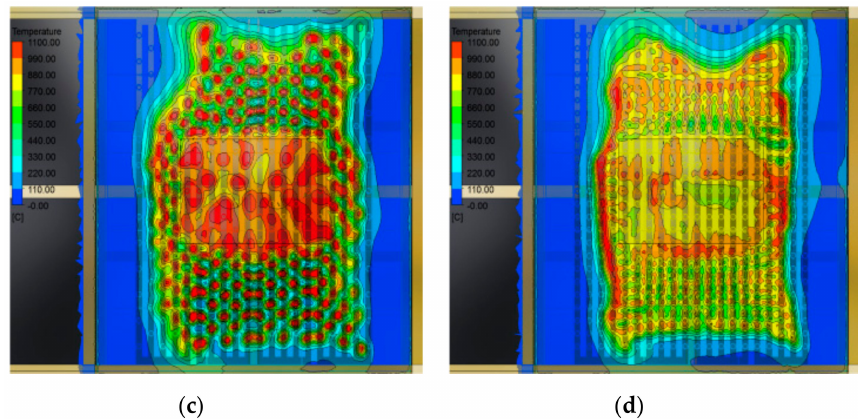
Figure 11. Temperature distribution at measurement plane (25 ± 10 mm downward from the bottom of mock-up): ( a ) test apparatus (A) with